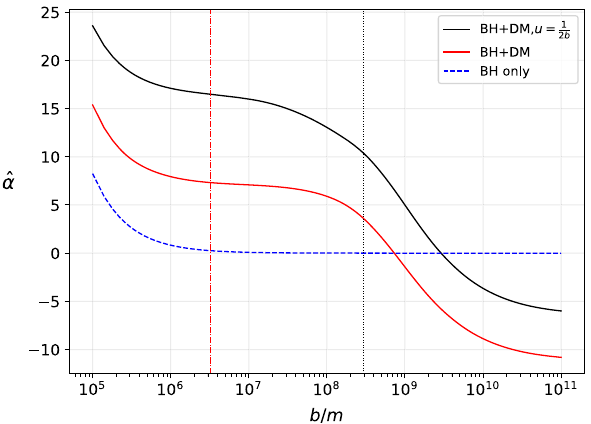
Fig. 5 Curve of the weak deflection angle in the URC profile for dif- ferent values of impact parameter b / m in M87. The vertical dotted line is the value of the outermost core radius r c ∼ 2 . 932 × 10 8 m . The region below the dash-dotted vertical line is the cusp region ( ∼ 3 . 214 × 10 6 m )